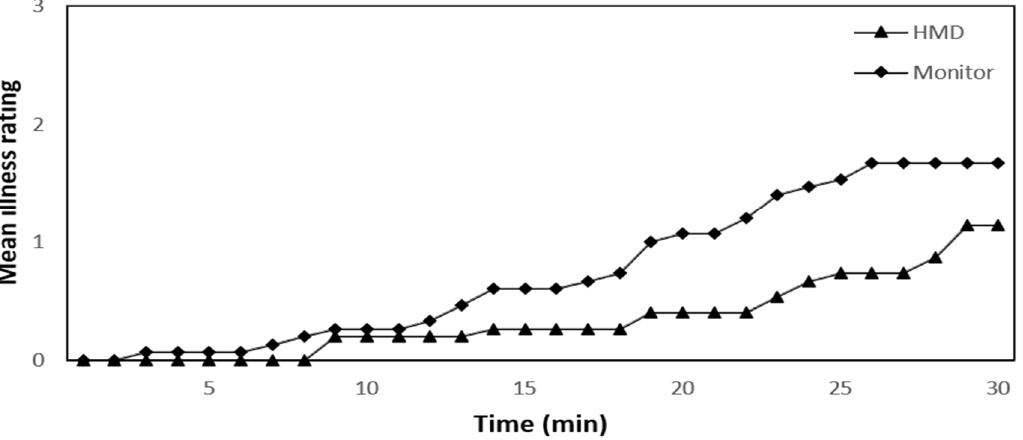
Figure 2. Mean illness ratings during the 30 min exposure to roll oscillation in the two visual conditions.